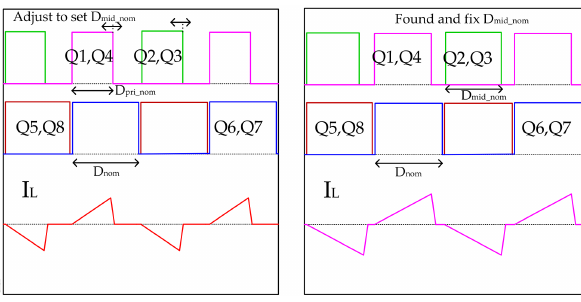
Figure 7. PWM signals plot at phase C soft-start mode.